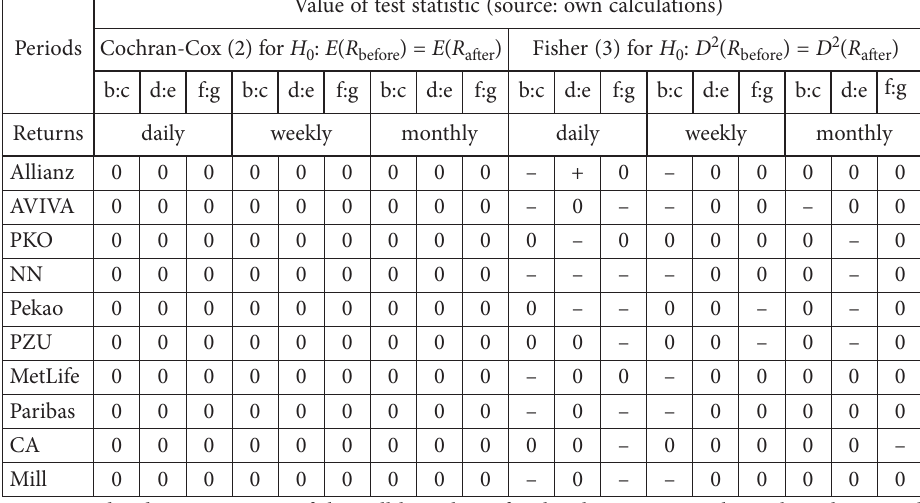
Table 6. Decisions based on statistics (2), (3) for returns and variances of mutual funds in the pairs of periods (source: own calculations) Value of test statistic (source: own calculations) Periods Cochran-Cox (2) for H 0 : E ( R before ) = E ( R after ) Fisher (3) for H 0 : D 2 ( R before ) = D 2 ( R after